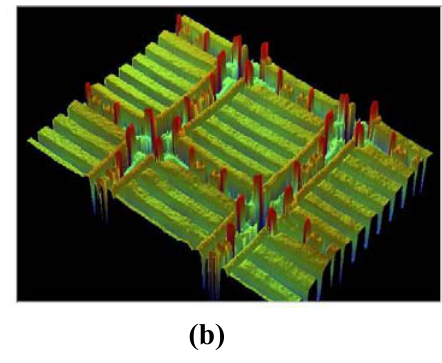
Figure 6. The photograph of the fabricated GLM array. (a) The SEM photograph of parts of a GLM array. (b) The VEECO photograph of parts of the fabricated GLM